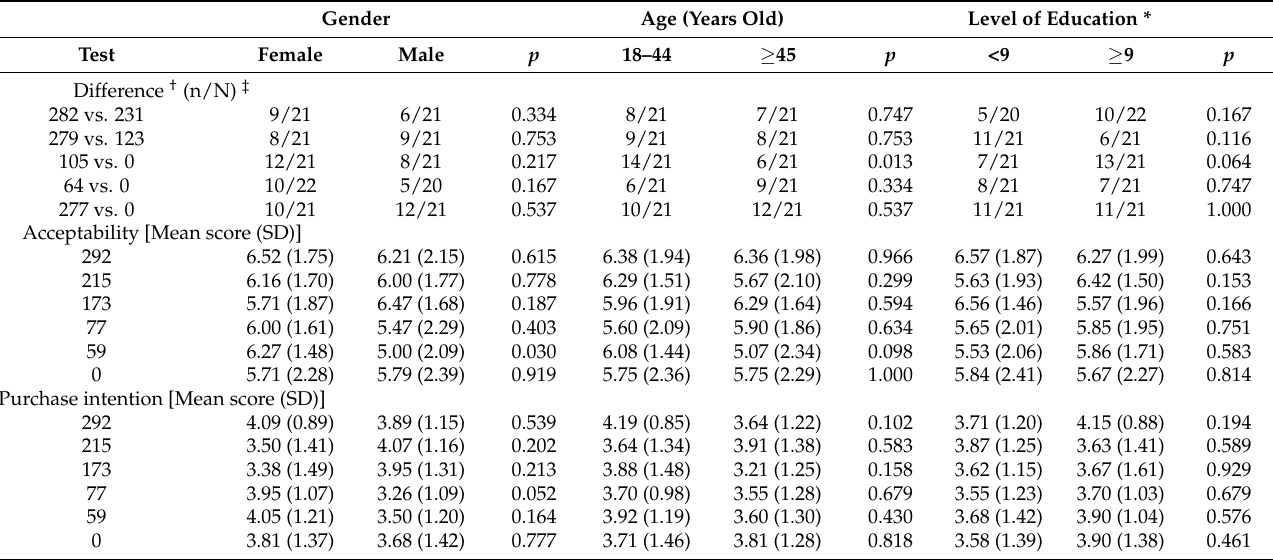
Figure 1. Results from difference testing; 14-number of correct answers by chance; 19-maximum number of correct answers until statistical significance. Table 2. Comparison of correct answers in difference testing and scores of acceptability and purchase intention testing, according to demographic